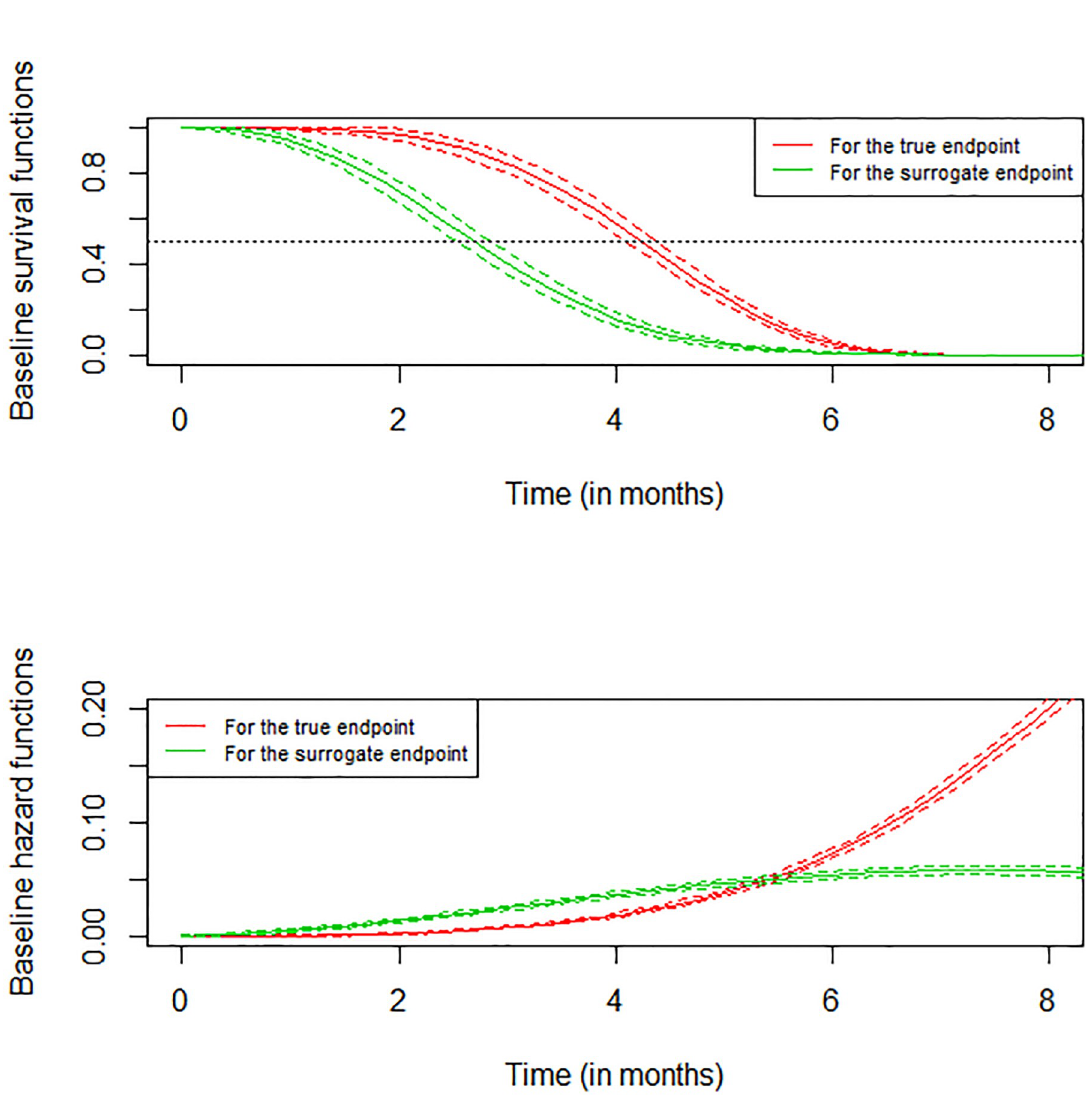
Fig 1. Baseline hazard and survival functions for surrogate endpoint and true endpoint truncated at 8 months using the advanced ovarian cancer meta-analysis dataset.